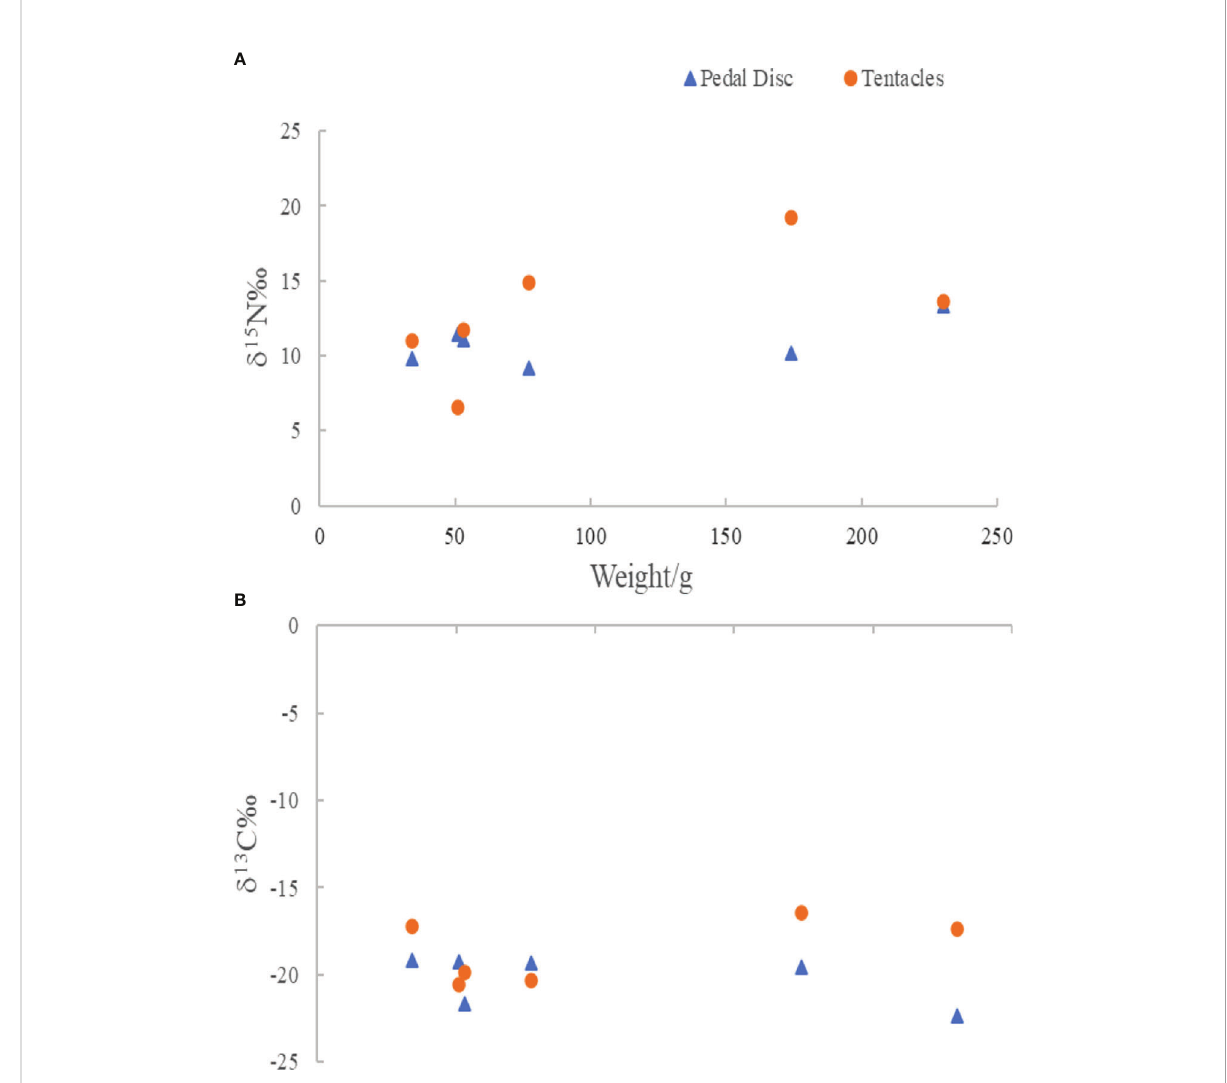
FIGURE 2 Differences in d 15 N (A) and d 13 C (B) among different tissues (foot disc and tentacles) of M.